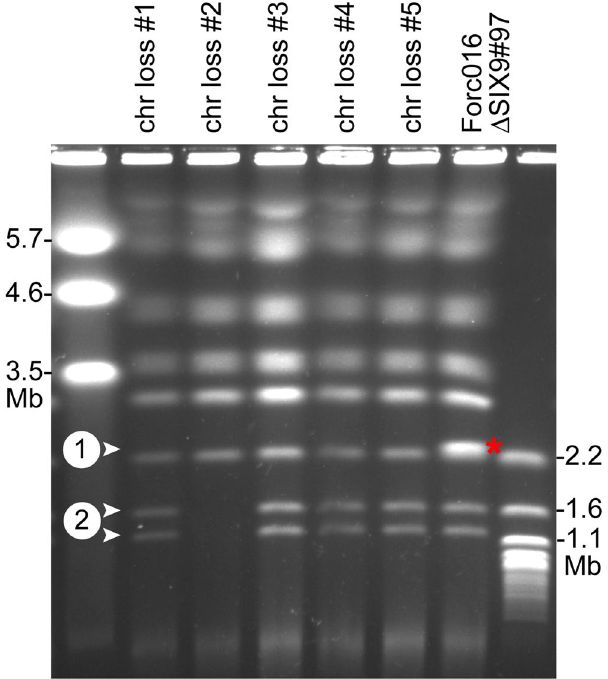
Figure 8. Chr RC and the two smaller accessory chromosomes of Forc016 are conditionally dispensable. Electrophoretic karyotyping shows complete absence of chr RC (marked with a red asterisk in lane 6) in all five hygromycin sensitive strains (arrowhead 1, lanes 1–5). Additionally, chromosome loss strain #2 displays absence of the two smallest chromosomes (arrowheads 2). The left and right lanes show the karyotypes of S . pombe and S . cerevisiae , respectively, applied as markers. This image is cropped, the original gel photograph can be found in Supplementary Fig.